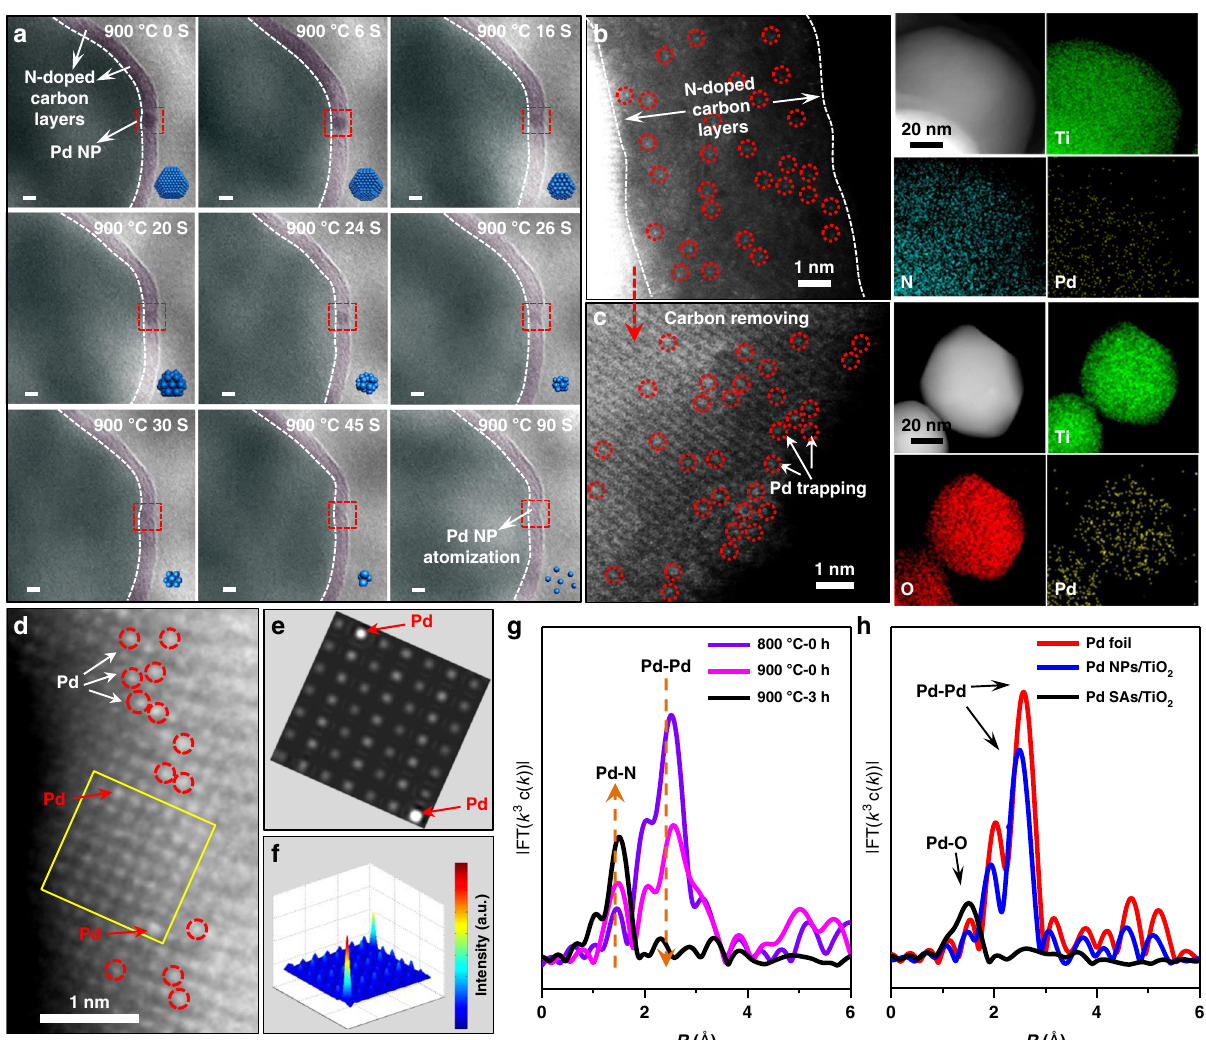
Fig. 2 NP-to-SA transformation of Pd and corresponding structural characterizations. a Representative movie images of Pd NPs/TiO 2 @C acquired at 900 °C at different times with in situ TEM under Ar atmosphere. b , c Aberration-corrected HAADF-STEM images and EDS mapping images of Pd SAs/ TiO 2 @C ( b ) and Pd SAs/TiO 2 ( c ). The HAADF image in ( b ) was taken from a region similar to the boxed one in ( a ). AC HAADF-STEM image ( d ) of Pd SAs/TiO 2 and the simulated image ( e ) obtained from the yellow rectangle in ( d ), and ( f ) the corresponding 3D surface intensity pro fi le image. Some of the Pd SAs in the HAADF images of ( b – d ) are highlighted by red circles. g Fourier-transformed (FT) k 3 -weighted Pd K-edge EXAFS spectra for Pd NPs/ TiO 2 @PDA during the annealing. h Fourier-transformed (FT) k 3 -weighted χ (k)-function of the EXAFS spectra for Pd K-edge of Pd SAs/TiO 2 and Pd NPs/ TiO 2. Scale bar, 5 nm for ( a ), 1 nm for AC HAADF-STEM images in ( b – d ), 20 nm for mappings in ( b , c